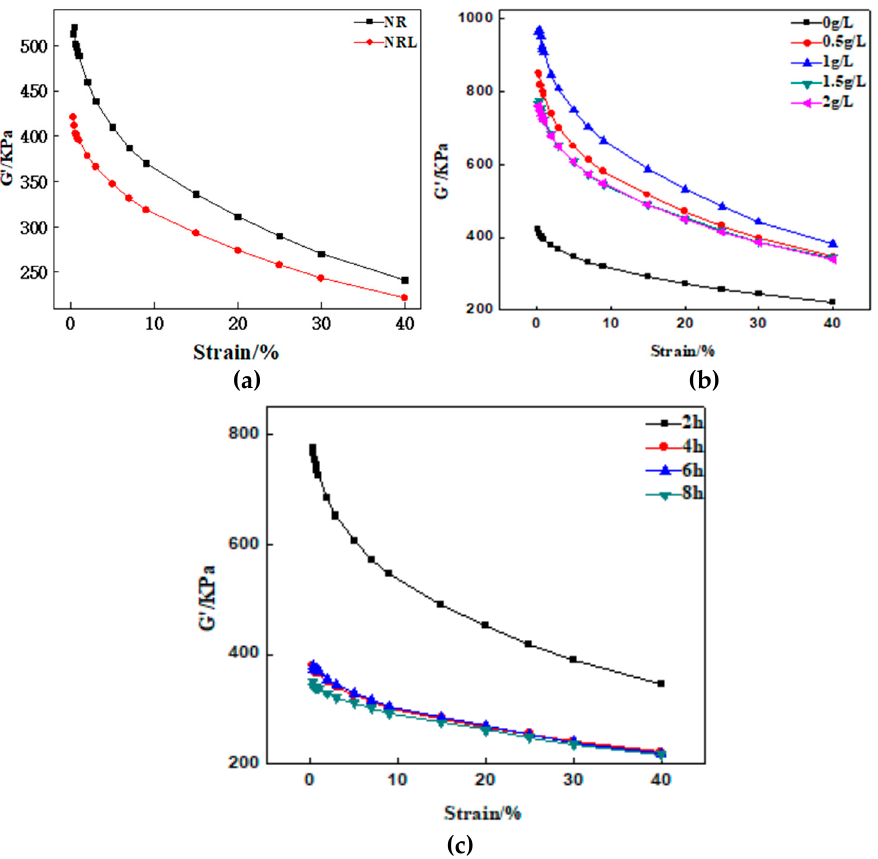
Figure 8. Viscoelasticity curve of composite: ( a ) viscoelasticity curve of CF with natural rubber and natural latex; ( b ) viscoelasticity curve of composites with CF modified by di ff erent concentrations of dopamine; ( c ) viscoelasticity curve of composites with CF modified by di ff erent processing times of dopamine.